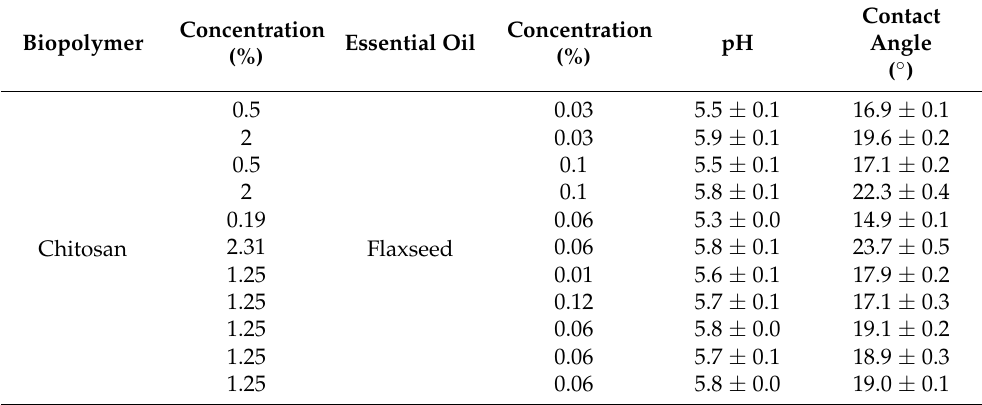
Table 2. pH and contact angle of the Ch–GTE (2%) coating solution formulations containing FO according to the CCRD